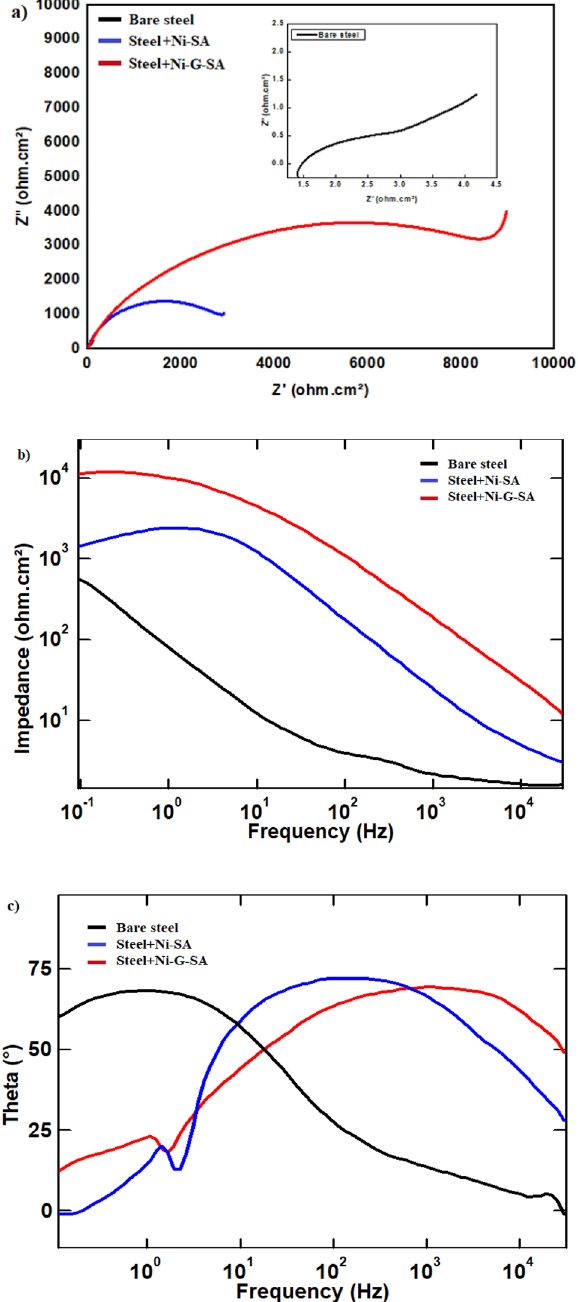
Figure 9. Nyquist and Bode plots of bare steel and superhydrophobic coated steel in 0.5 M NaCl solution.